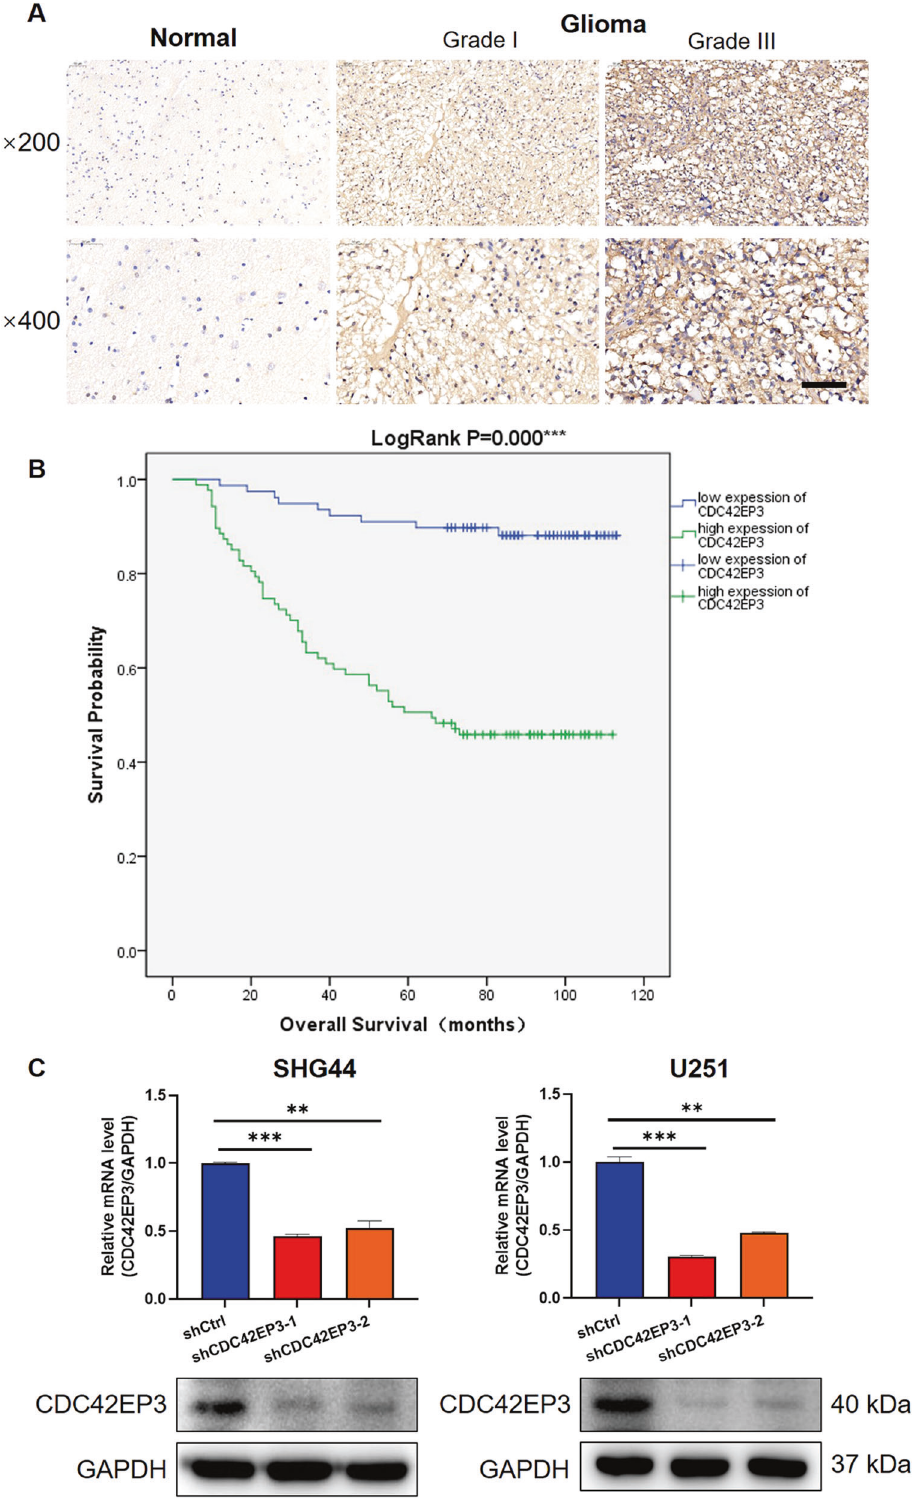
Fig. 1 CDC42EP3 is upregulated in glioma and correlated with poor prognosis. A Representative photographs of human glioma tissues and normal brain tissues after immunohistochemistry staining of CDC42EP3. The scale bar is 50 µm long. B Glioma patients with high expression of CDC42EP3 undergoes relatively shorter overall survival in comparison with those with low CDC42EP3 expression. C The relative mRNA levels of CDC42EP3 in SHG-44 and U251 cells and differences between shCtrl- and shCDC42EP3-harboring cells detected by qPCR and WB. Data were presented by mean with SD ( n ≥ 3). ** P < 0.01, *** P < 0.001.